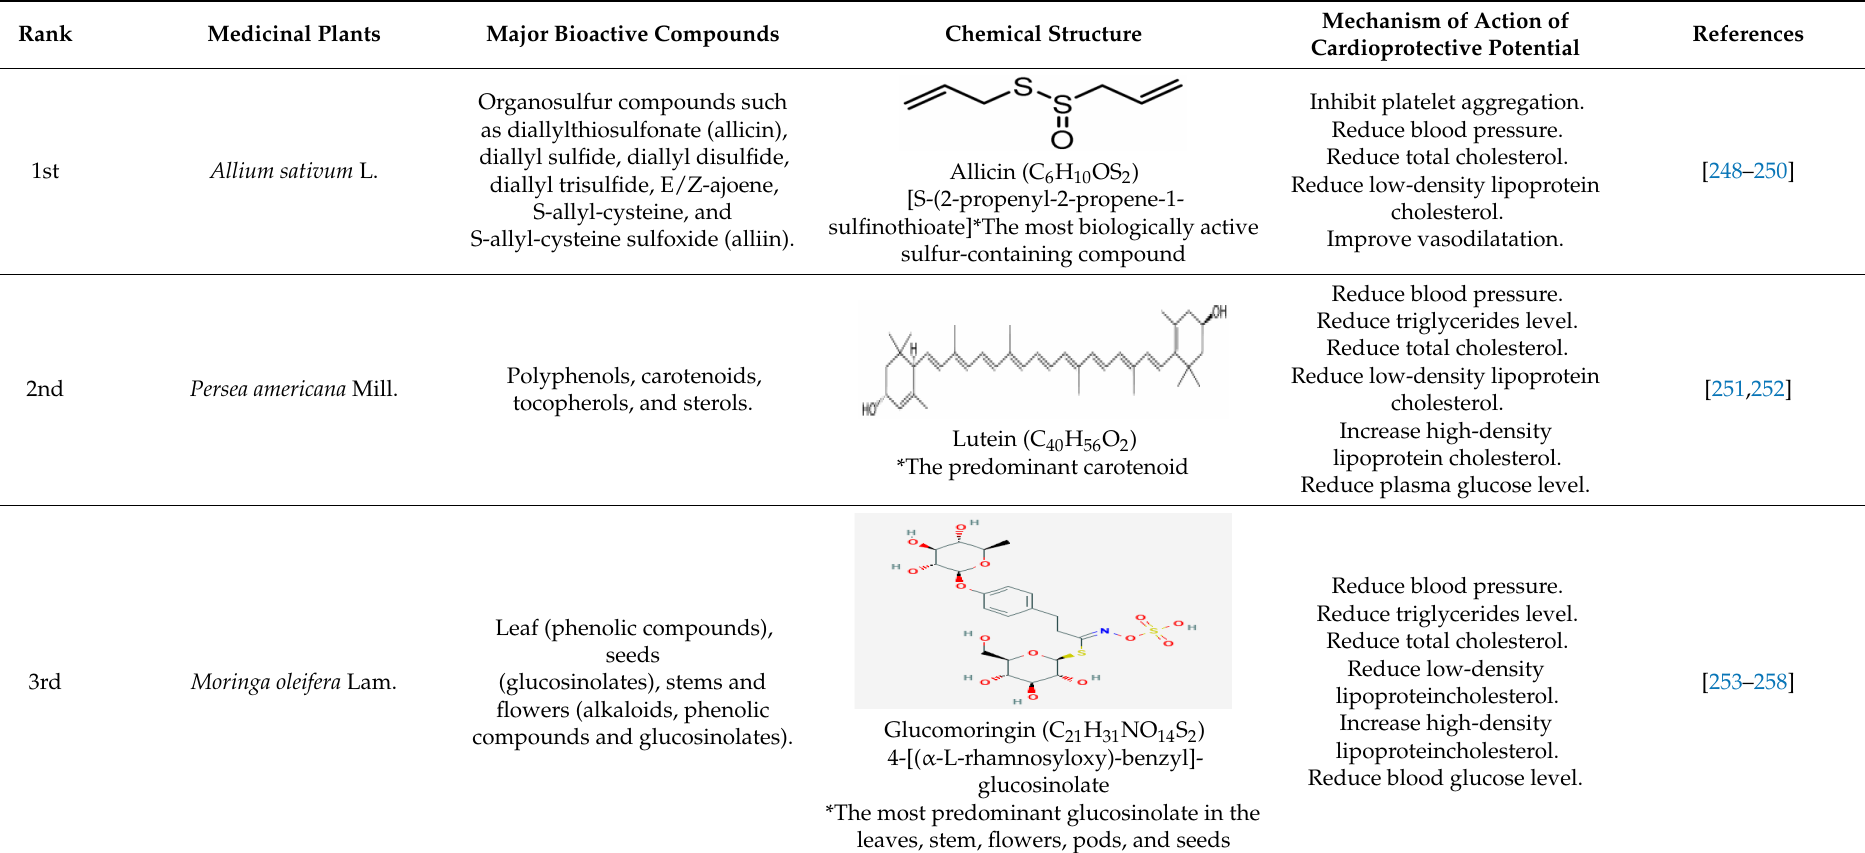
Table 4. Major bioactive compounds in the five most preferred medicinal plants for the treatment of cardiovascular diseases in sub-Saharan